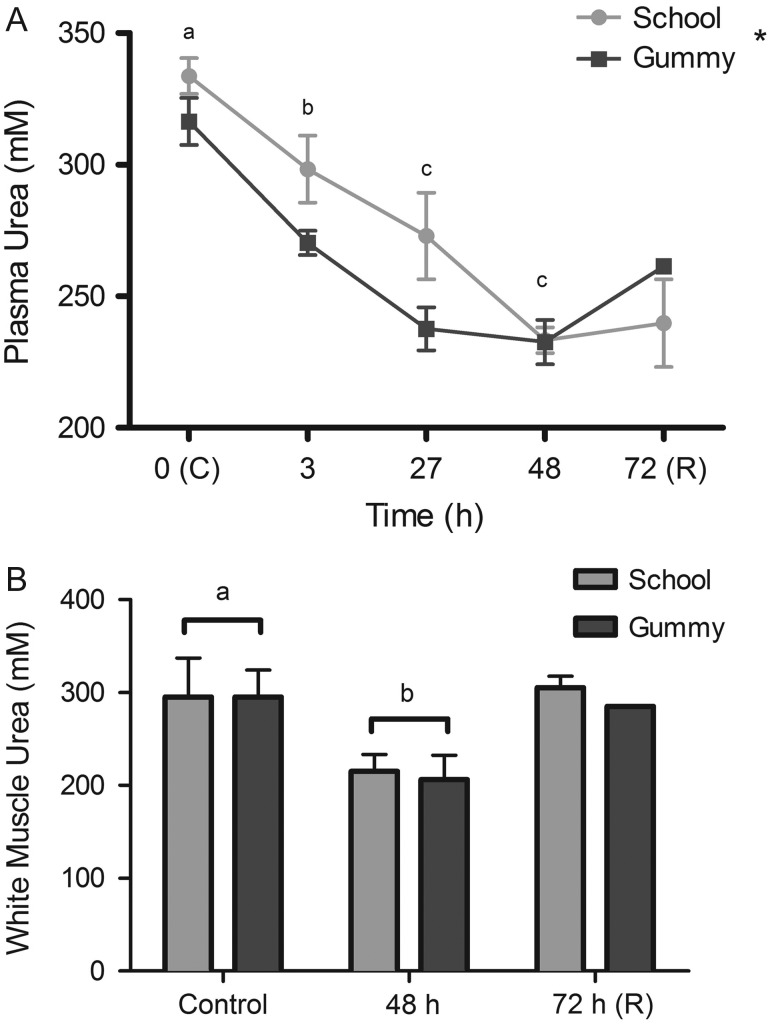
Urea concentration (in millimoles per litre; mean
values ± SEM) in the plasma (A) and white
muscle (B) of school sharks (G. galeus) and
gummy sharks (M. antarcticus) following exposure to
75% seawater. Different letters indicate statistically significant
differences over time (P < 0.05; see
Materials and methods for species replication numbers). Asterisks indicate a
statistically significant effect of species
(P < 0.05). Recovery (R) data are not
included in the statistical analyses.